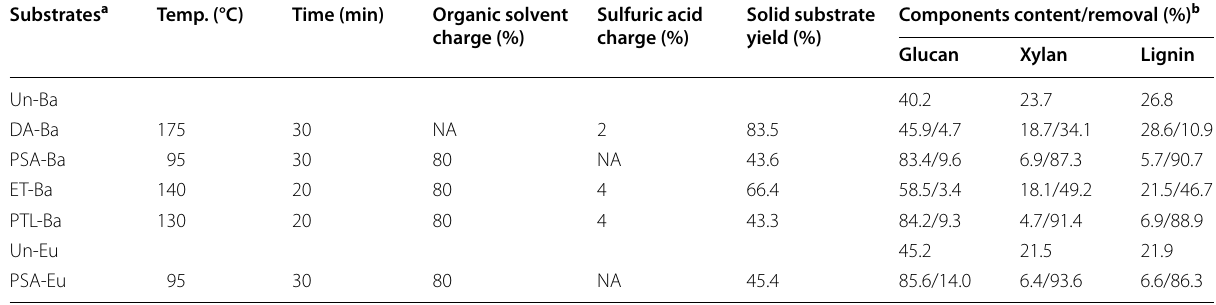
a Un-Ba and Un-Eu represent untreated bamboo and eucalyptus particles; PSA-Ba, ET-Ba, DA-Ba, PTL-Ba, PSA-Eu are the abbreviations of phenylsulfonic acid (PSA), ethanol (ET), dilute acid (DA) and n-pentanol (PTL) pretreated bamboo (Ba), and phenylsulfonic acid (PSA) pretreated eucalyptus (Eu) substrates, respectively b The data before slashes are the contents of the components in raw materials (o.d.) and pretreated substrates (o.d.), while the data after slashes refer to the removal (Eq. (1)) of specific component